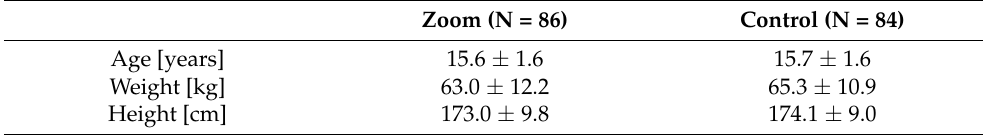
Table 1. Anthropometric data of the